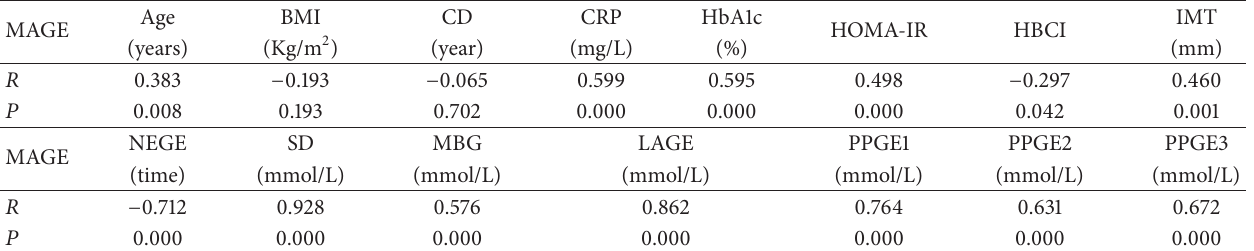
Table 4: Linear correlation analysis between MAGE and the related factors in groups B and